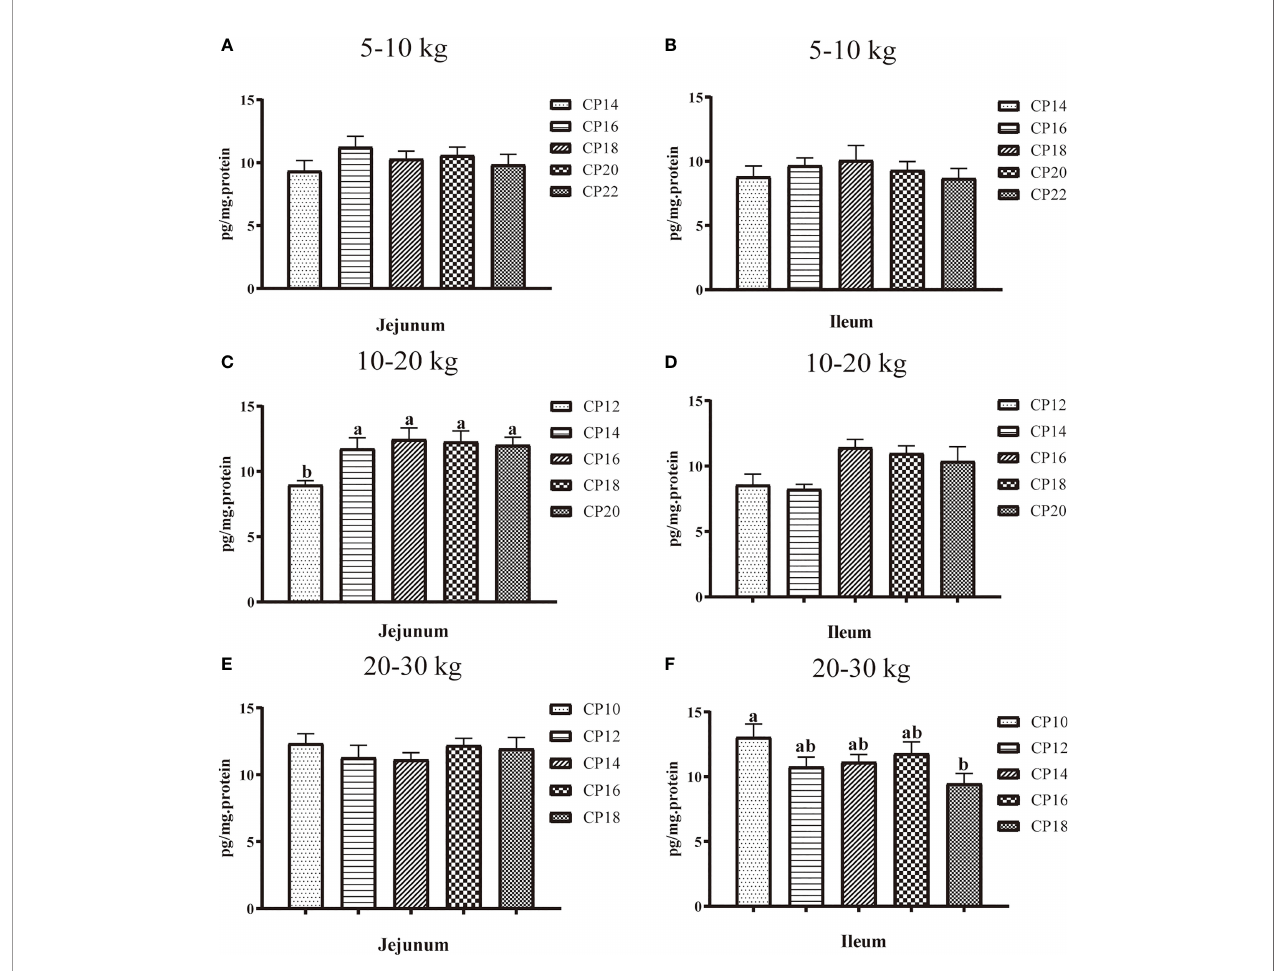
FIGURE 4 | Effects of dietary crude protein (CP) levels on the small intestinal mucosa sIgA concentration of Huanjiang mini-pigs during 5 − 10 kg ( A , jejunum; B , ileum), 10 − 20 kg ( C , jejunum; D , ileum), and 20 − 30 kg ( E , jejunum; F , ileum) growth stages. Data are presented as means ± SE ( n = 6 − 8 per group). Different superscript letters indicate signi fi cant differences among the fi ve groups ( P < 0.05). sIgA, secretory immunoglobulin